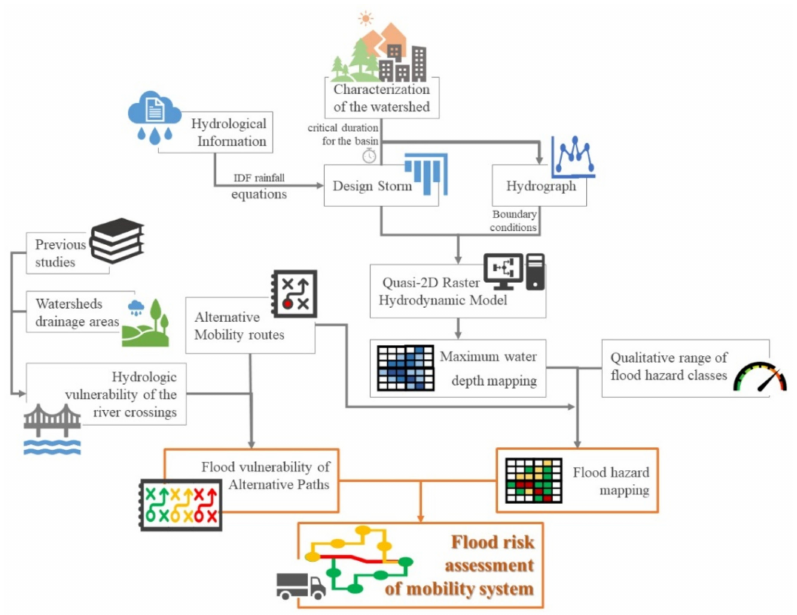
Figure 1. Adopted